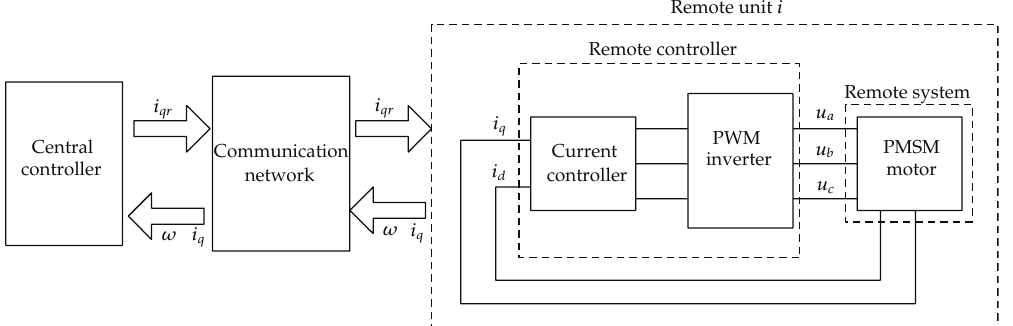
Figure 3: The diagram of a networked PMSM servo system.